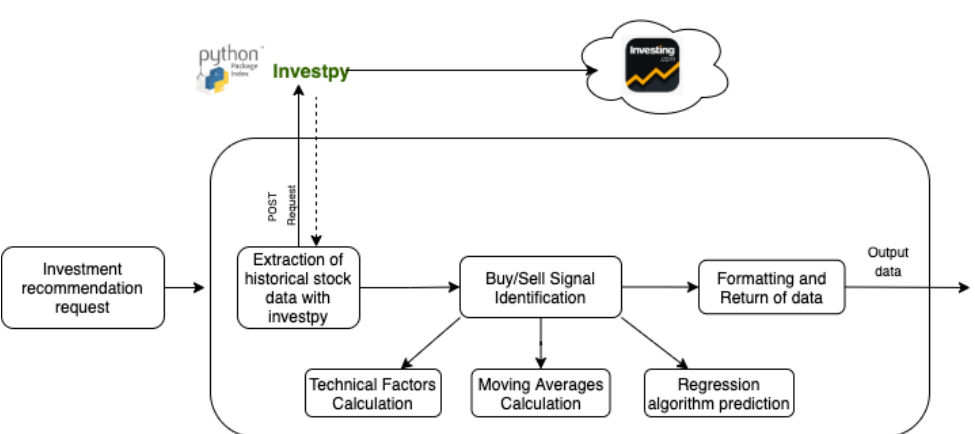
Figure 8. Recommender System Package Design